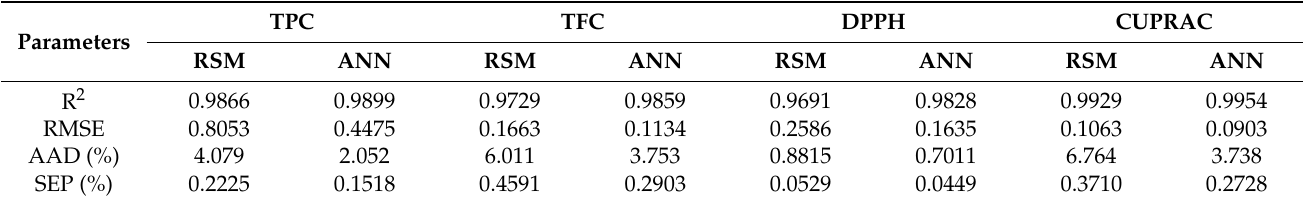
Table 3. Comparison of the prediction abilities of the RSM and ANN